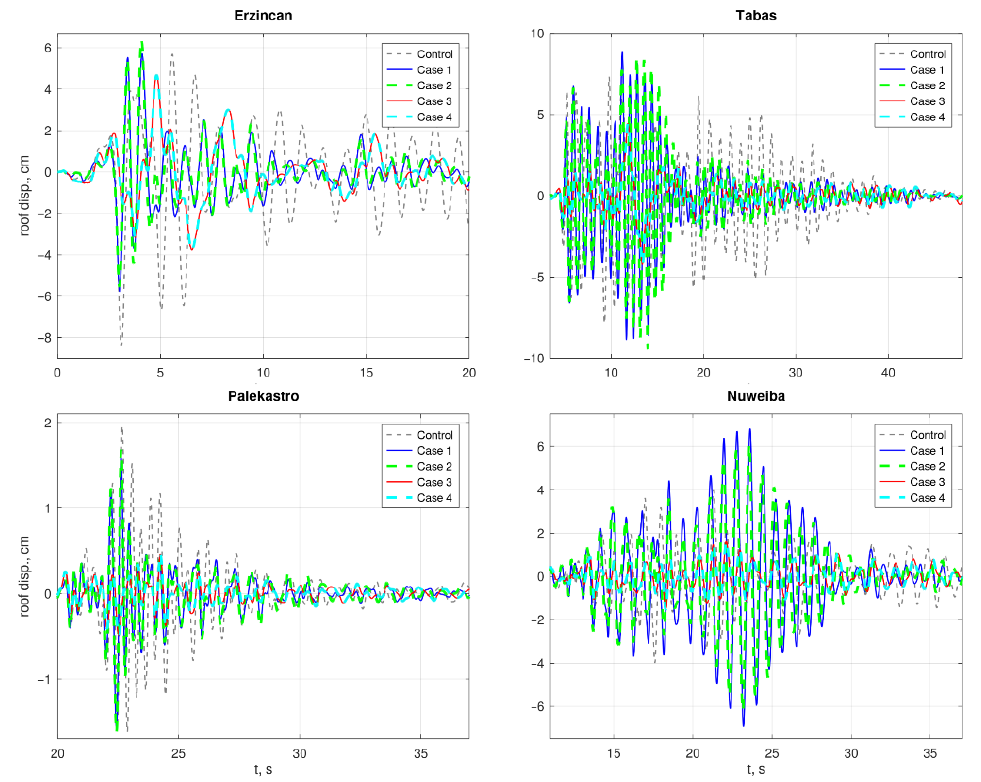
Figure 6. Roof displacement’s time history responses to each earthquake.